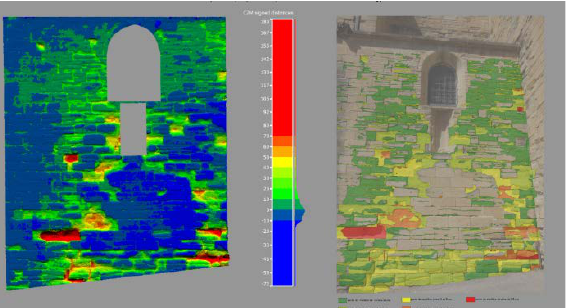
Figure 23. Comparison between traditional and digital cartography: deviation map from the RANSAC plan.